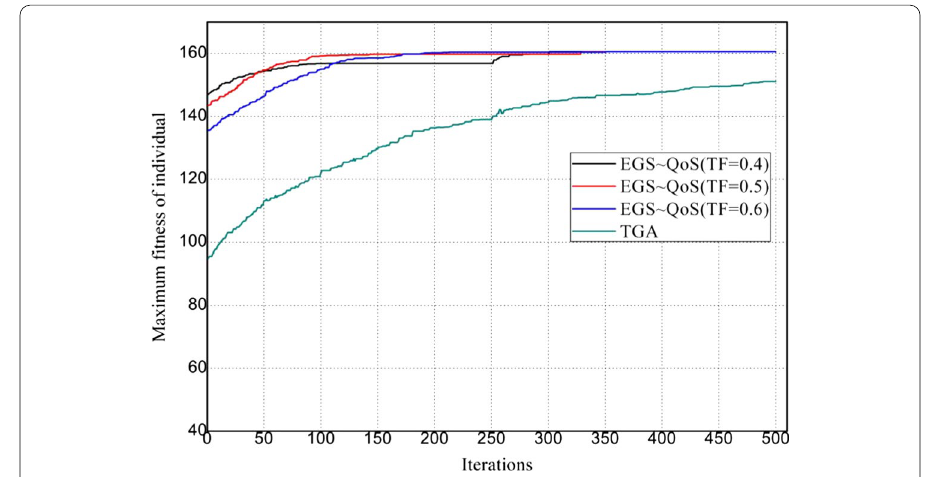
Fig. 5 Maximum fitness of individual for n